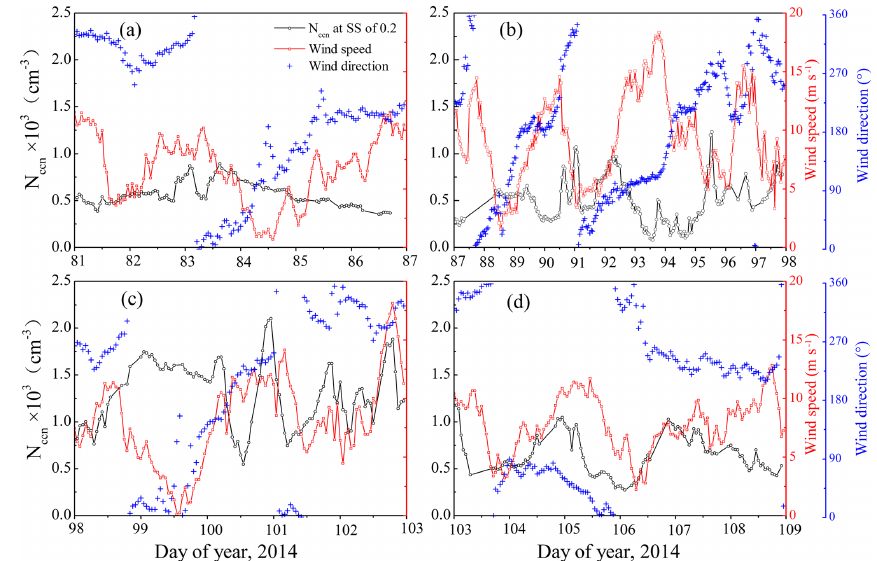
Figure 6. Time series of the N ccn , wind speed and wind direction at SS of 0.2% during the measurement for the four periods, including Period 1 (a) , Period 2 (b) , Period 3 (c) and Period 4 (d)